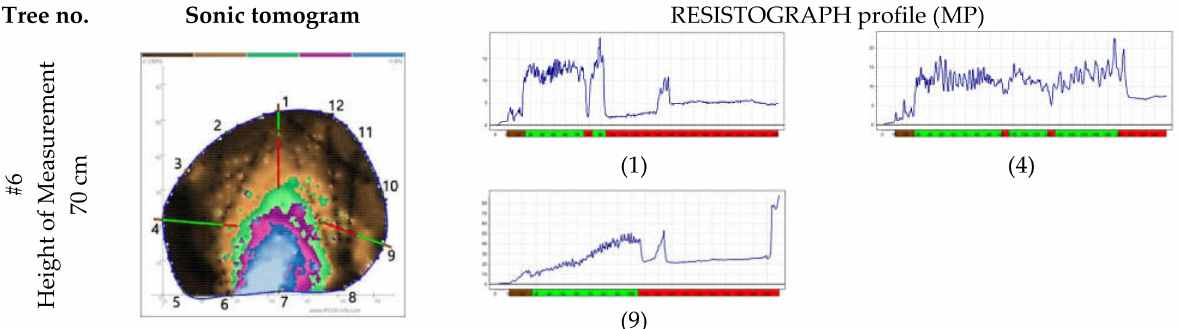
Figure 1. Sonic tomograms superimposed with the RESISTOGRAPH profile for selected drilling measurement points (MPs). In the sonic tomograms and resistance profiles graphs, green lines indicate the depth of the drilling path and sound region, red lines represent the depth of the decay region, and brown lines represent bark. In the sonic tomograms, brown: healthy woods, red and blue: defects, green: initial decays.